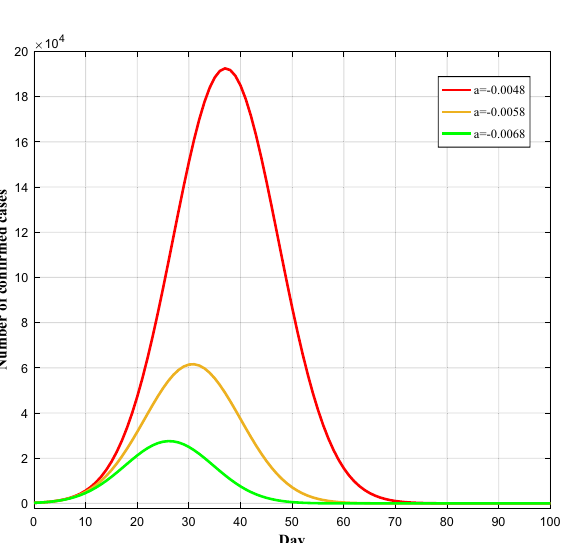
Figure 7. Comparison between observed and predicted prevalence curve of COVID-19.